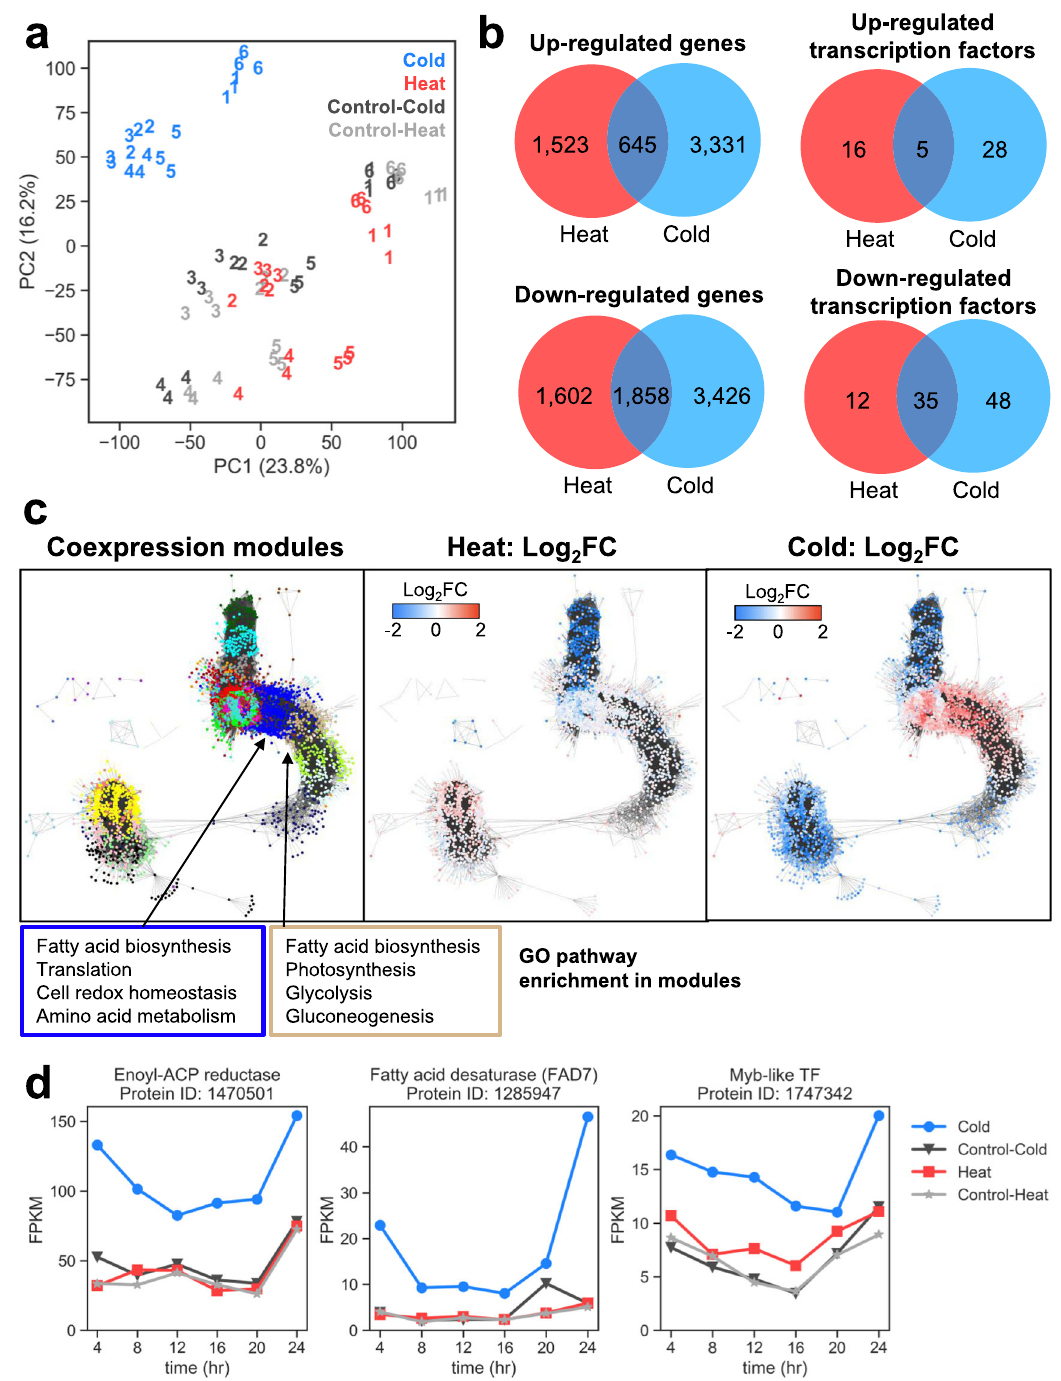
Fig. 7 Transcriptomics pro fi le of Scenedesmus sp. NREL 46B-D3 in response to cold stress and heat stress conditions. a A principal component analysis of the gene expression data colored by condition: cold stress (blue), heat stress (red), and controls (gray) and labeled by time point, with three replicates for each. The time points correspond to the following times over the sampling period: 1 – 4 h, 2 – 8 h, 3 – 12 h, 4 – 18 h, 5 – 20 h, 6 – 24 h. b Venn diagram of differentially expressed transcription factors in at least one time point across the cold stress and heat stress samples compared to the control samples. c Gene co-expression network calculated using weighted gene co-expression network analysis (WGCNA) with genes colored by modules (left), average fold change in the heat samples (middle), and average fold change in cold samples (right). Enriched GO processes for modules that are enriched with fatty acid biosynthesis genes are listed, and the borders are colored by modules shown in the co-expression network. d Gene expression pro fi les over time for several upregulated genes in cold stress, including enoyl-ACP reductase ( ENR1 ), omega-3 fatty acid desaturase ( FAD7 ), and a MYB-like transcription